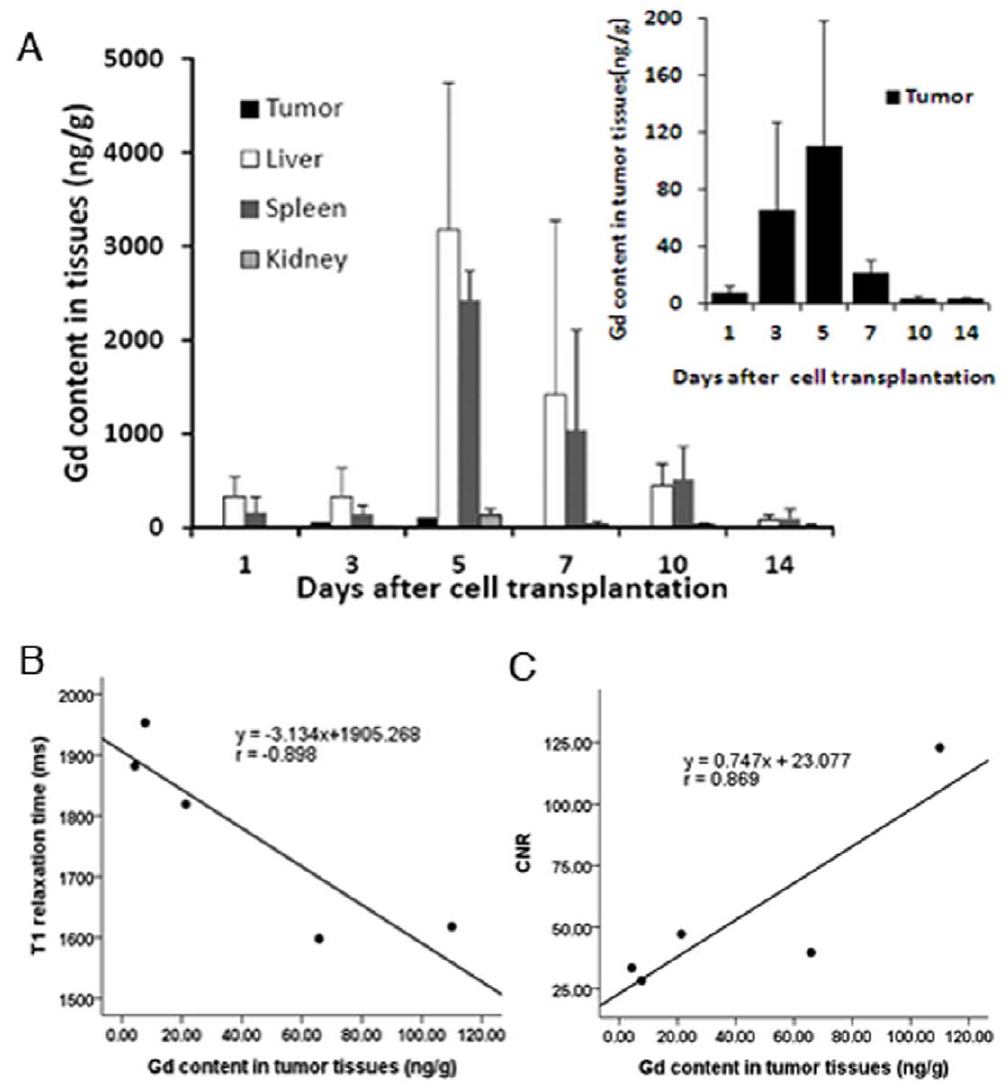
Figure 6. The amount of Gd in each organ. (A) The levels of Gd in the liver and spleen are much higher than that of tumor tissues; the concentration of Gd in the tumor reached peak at day 5. (B) A linear correlation ( r = 2 0.898, p , 0.05) was found between the averaged Gd content in the tumor and intratumoral T 1 relaxation time. (C) The correlation between the averaged Gd content in the tumor and CNR of the tumor was significant ( r =0.869, p , 0.05).